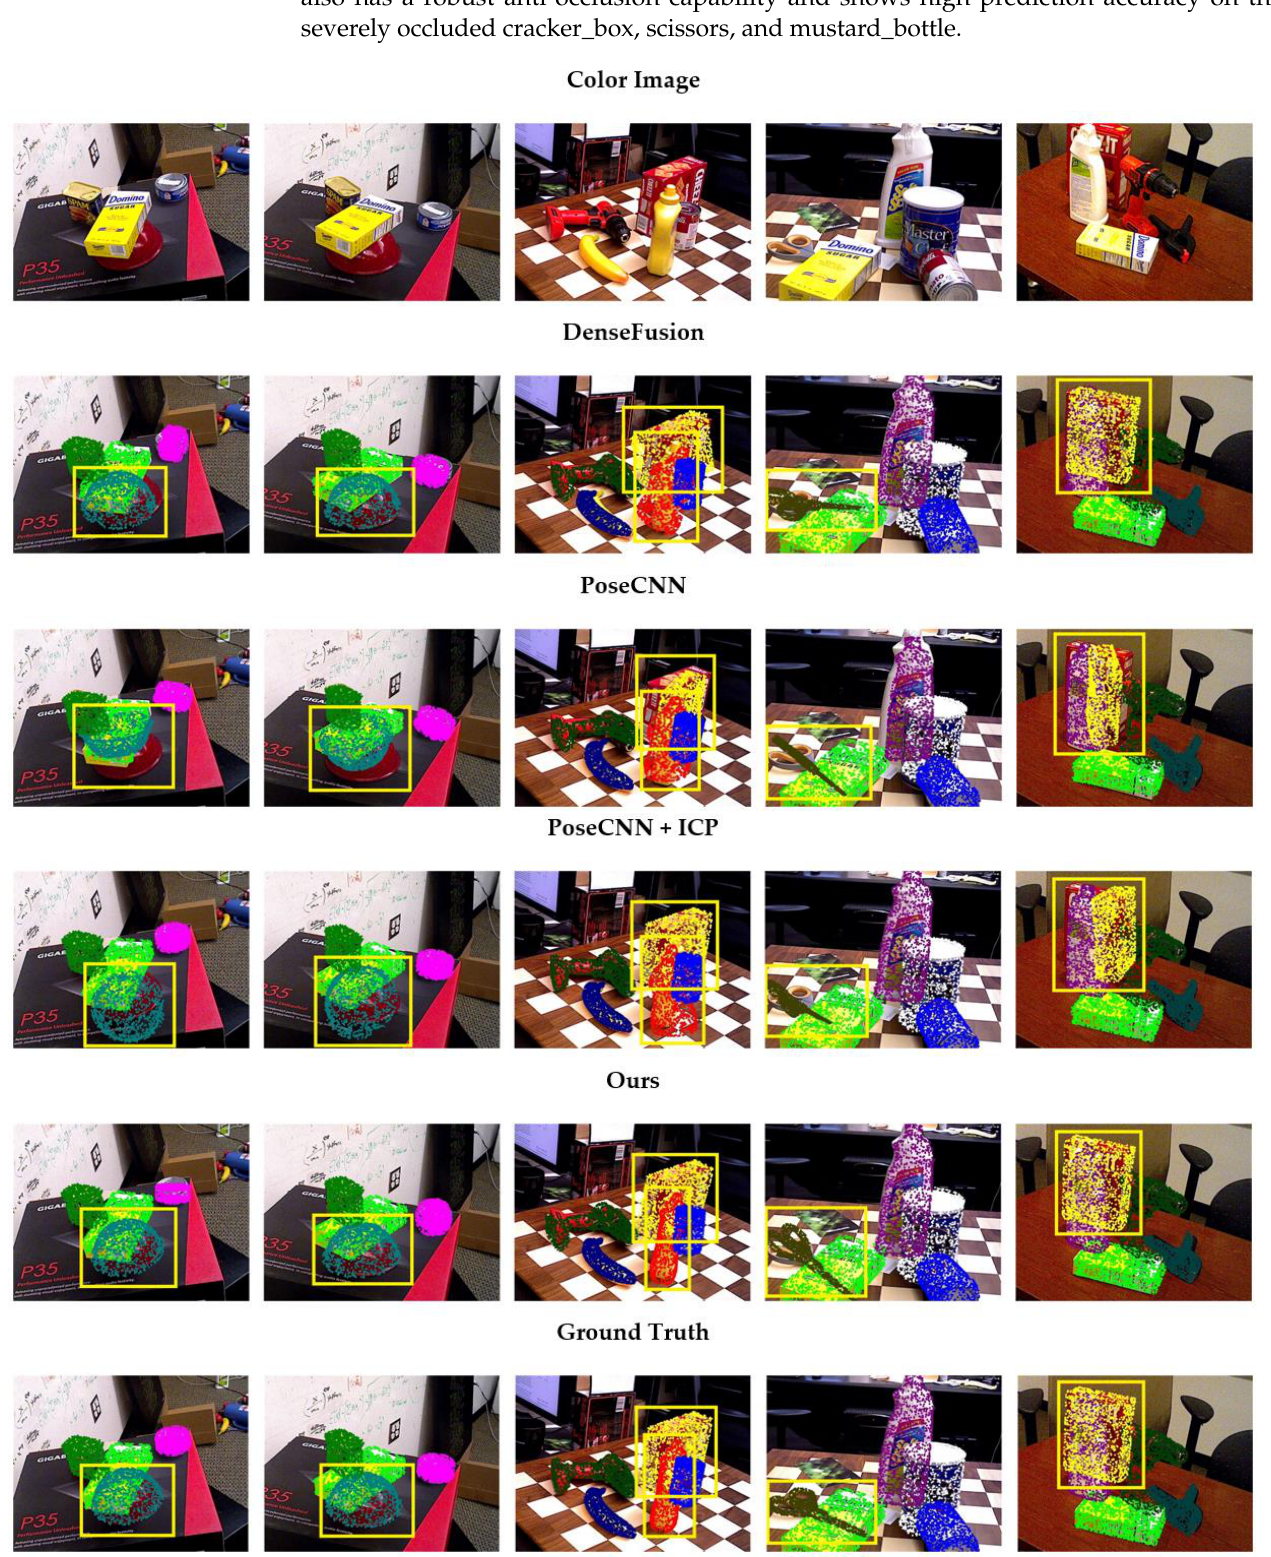
Figure 6. Qualitative results of the YCB-Video Dataset. The yellow box in the image shows that our method profoundly outperforms other methods on this object (from left to right: bowl, cracker_box, mustard_bottle, scissors, and cracker_box).